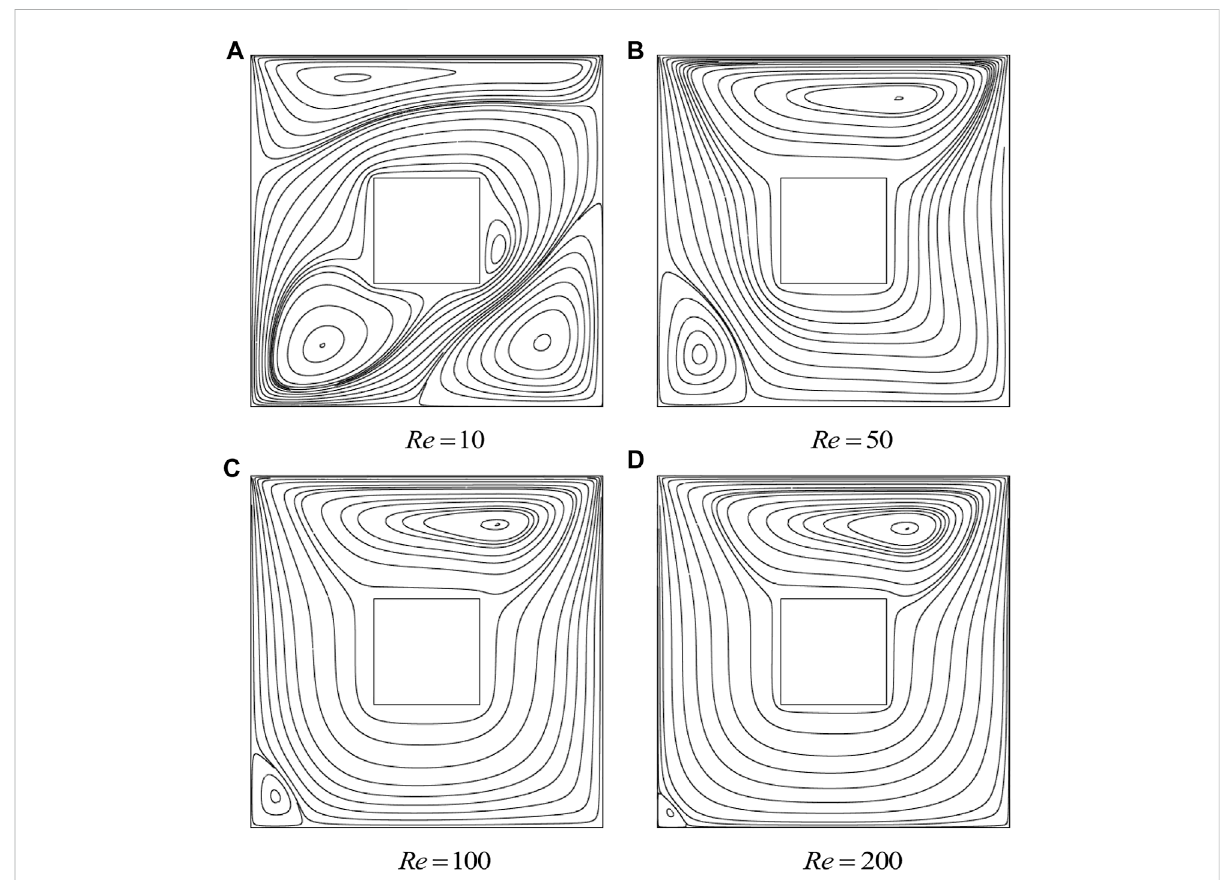
FIGURE 5 In fl uence of Re on streamlines with a uniformly heated bottom wall: cold cylinder case, Ha (cid:2) 20 and Re (cid:2) 10 4 .